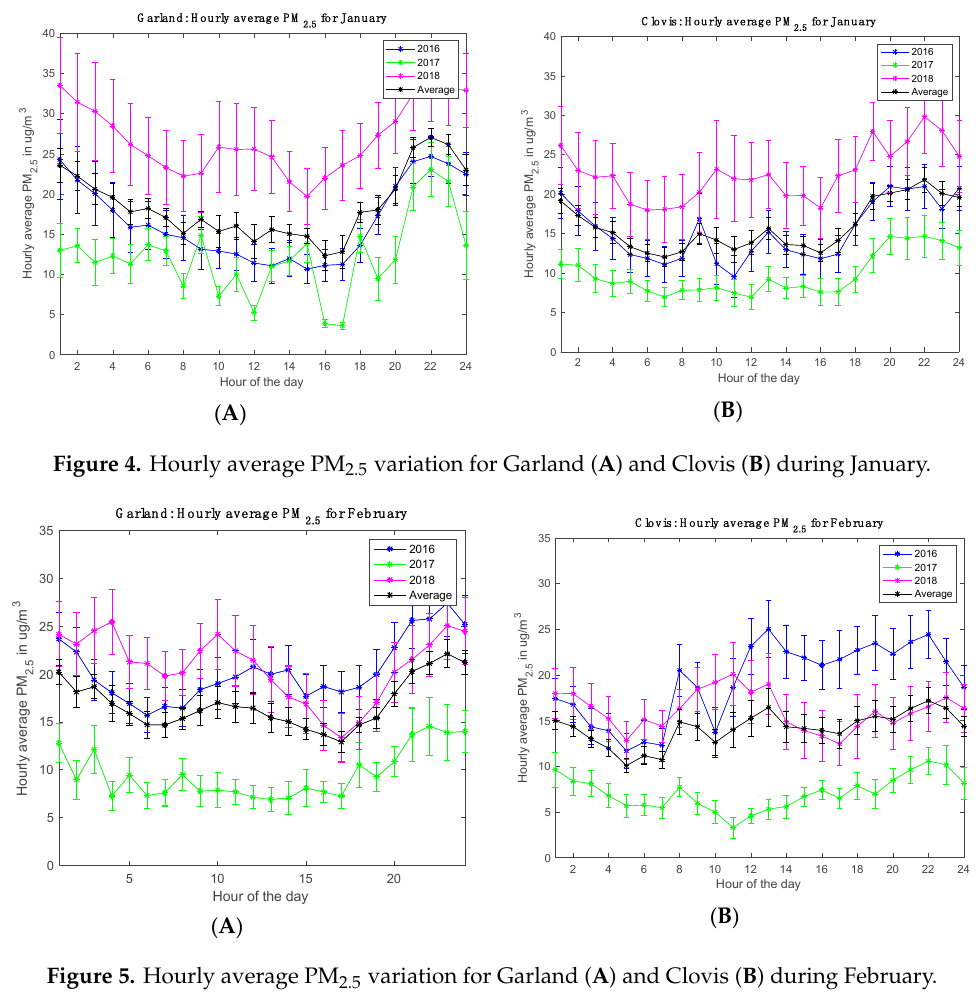
Figure 3. Hourly average PM 2.5 variation for Garland ( A ) and Clovis ( B ) during December.